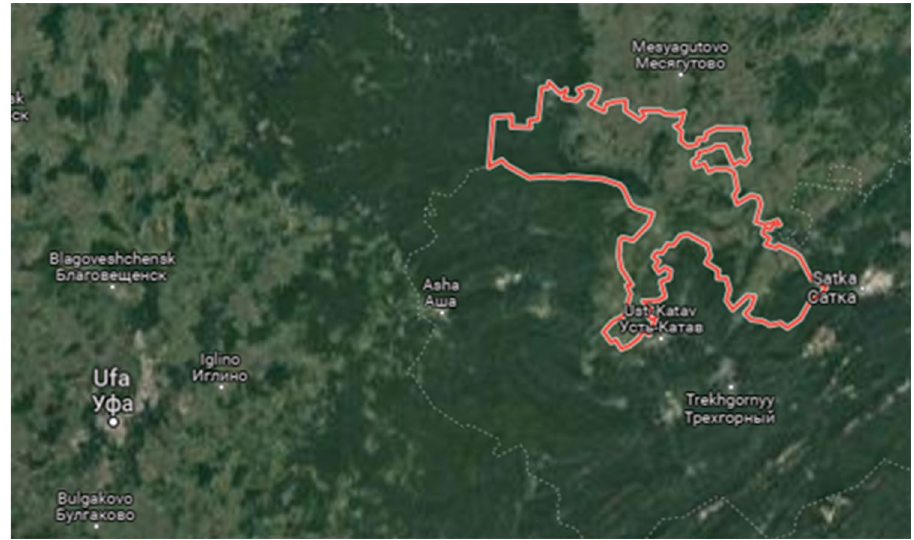
Figure 1. Location of the area of the studied